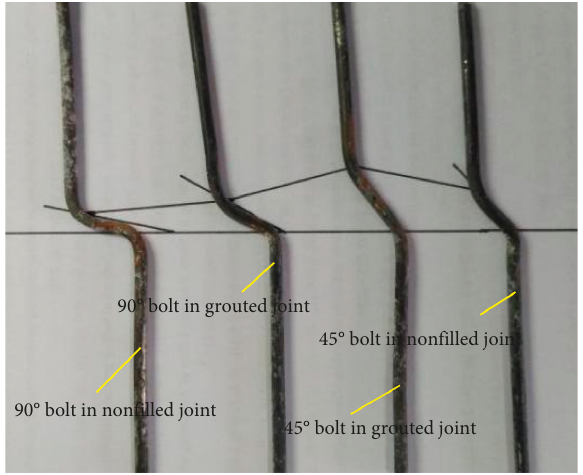
Figure 8: Deformation of the rock bolt with a different inclination.